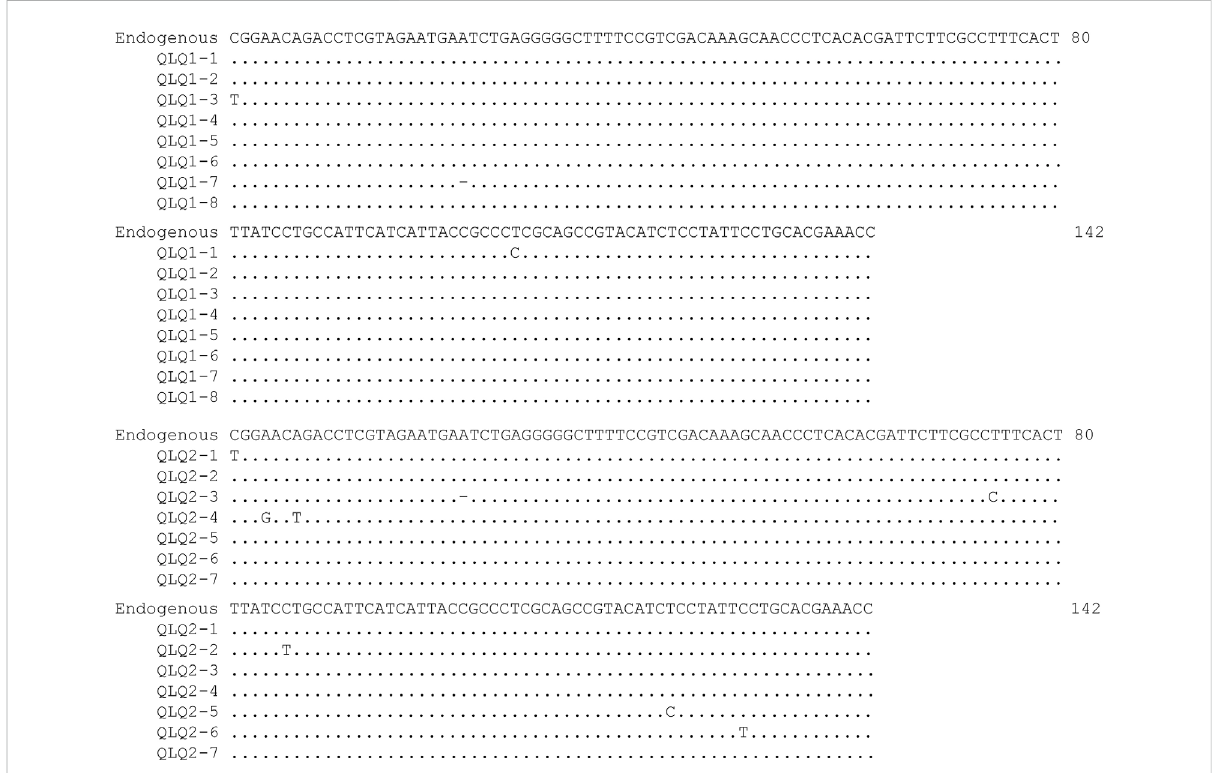
Alignment of the achieved Cytb clones of two Qinglongquan pig samples using L-PCR without UNG treatment. The “ Endogenous ” sequence is determined by the results of ampli fi cation after UNG treatment. Nucleotides identical to the endogenous sequence are indicated by